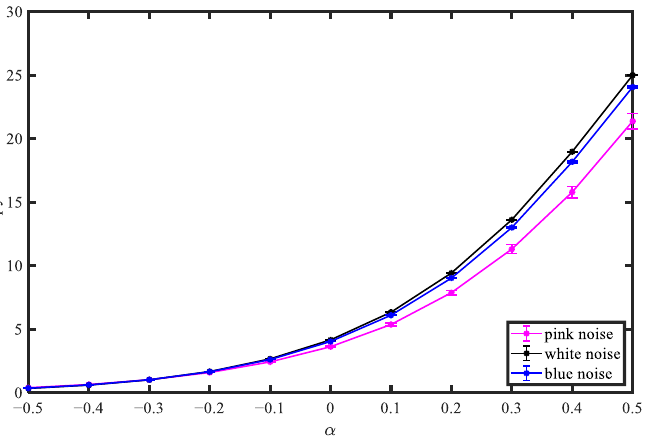
Figure 5. Means and standard deviations of different fractional order entropies under noise sig-